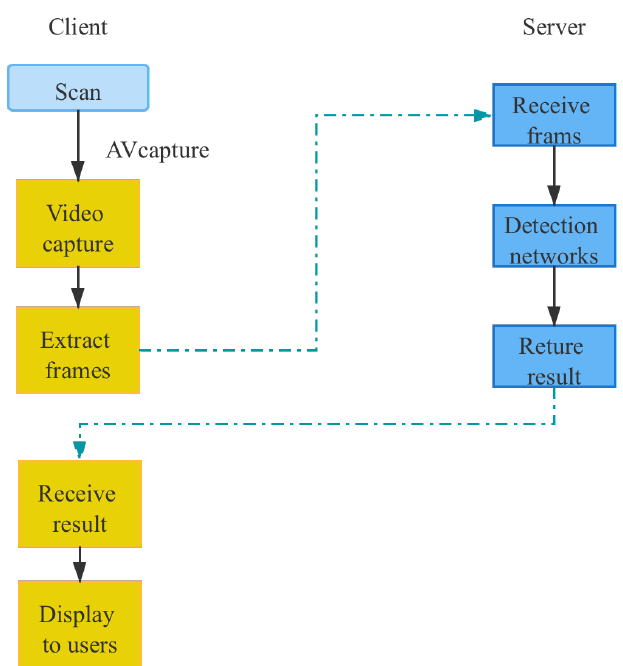
Figure 14. Intelligent pear defect detection system flow chart.